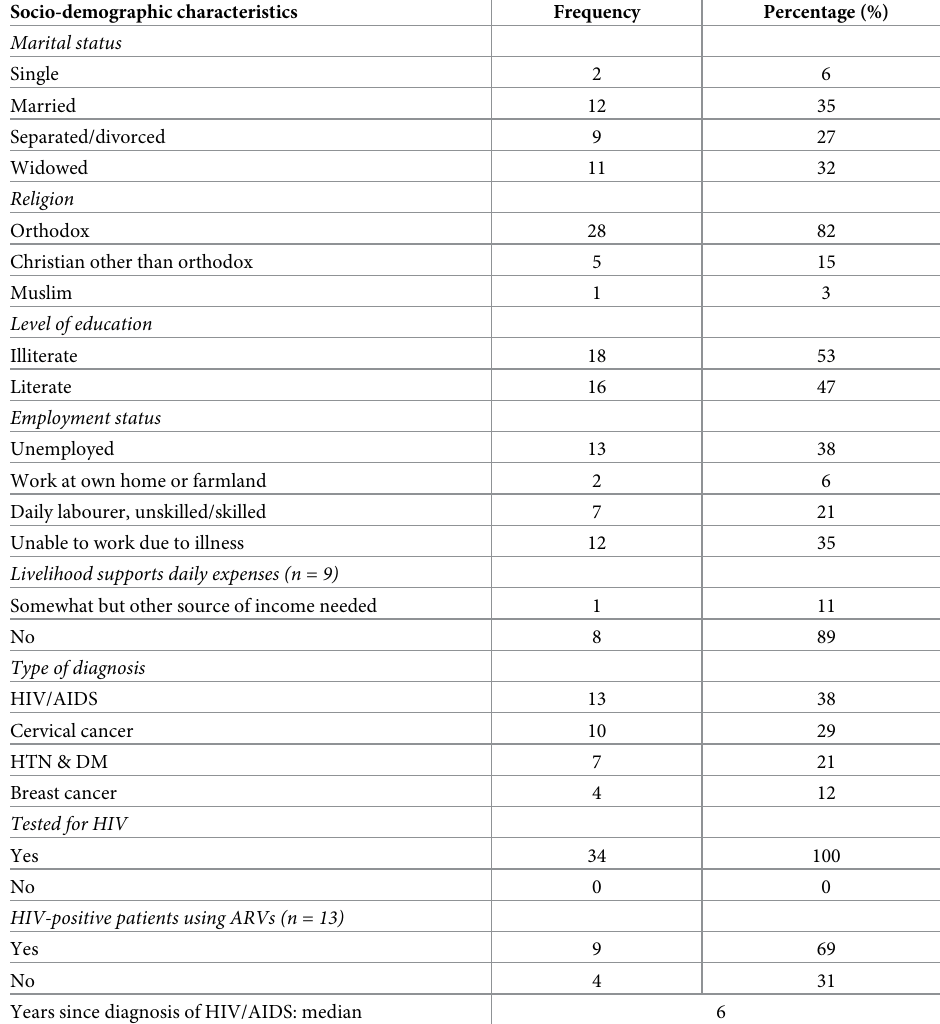
Table 1. Socio-demographic characteristics of patients (n = 34). Socio-demographic